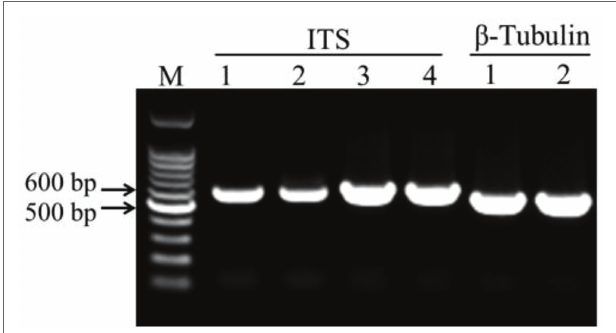
FIGURE 3 | Amplification of conserved gene fragments in filamentous fungi. M: marker. 1. Standard strain Aspergillus niger . 2. Strain HYS. 3. Strain HQS- 1. 4. Strain HQS-2.